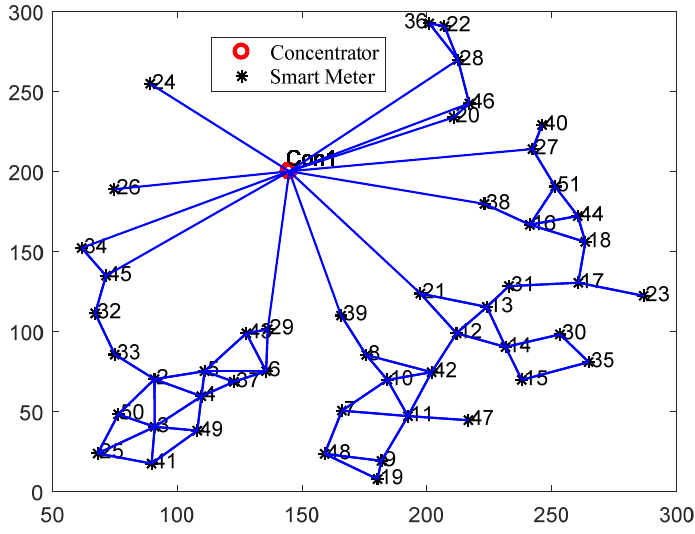
Figure 14. Logical topology between the concentrator and the smart meters.